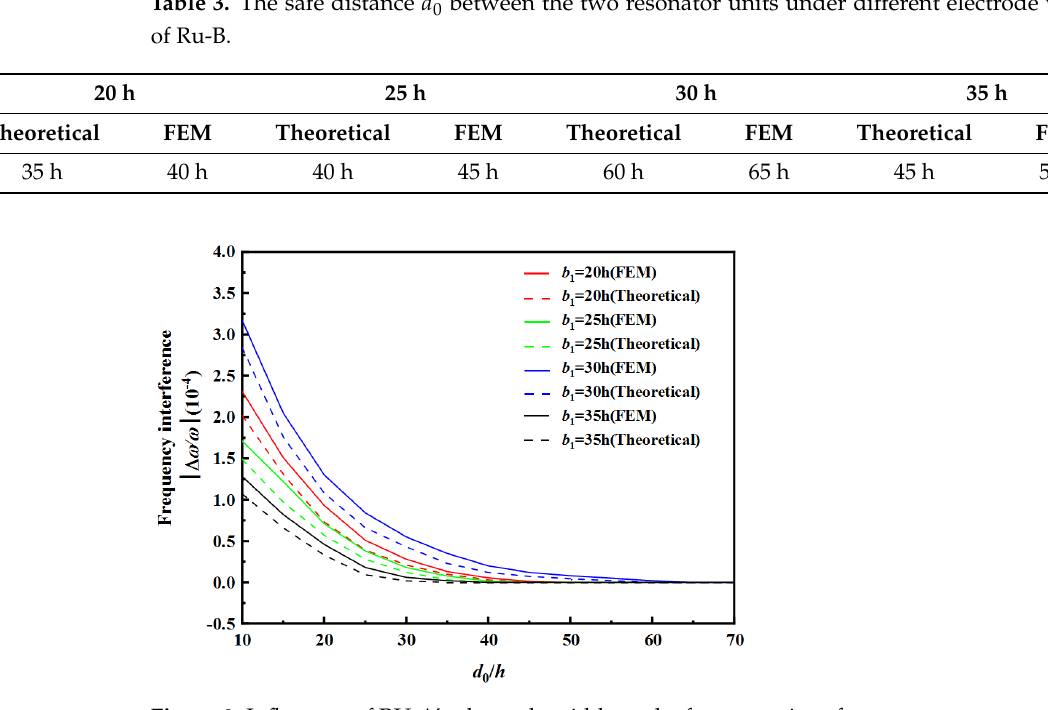
Figure 8. Influences of RU-A’s electrode width on the frequency interference.